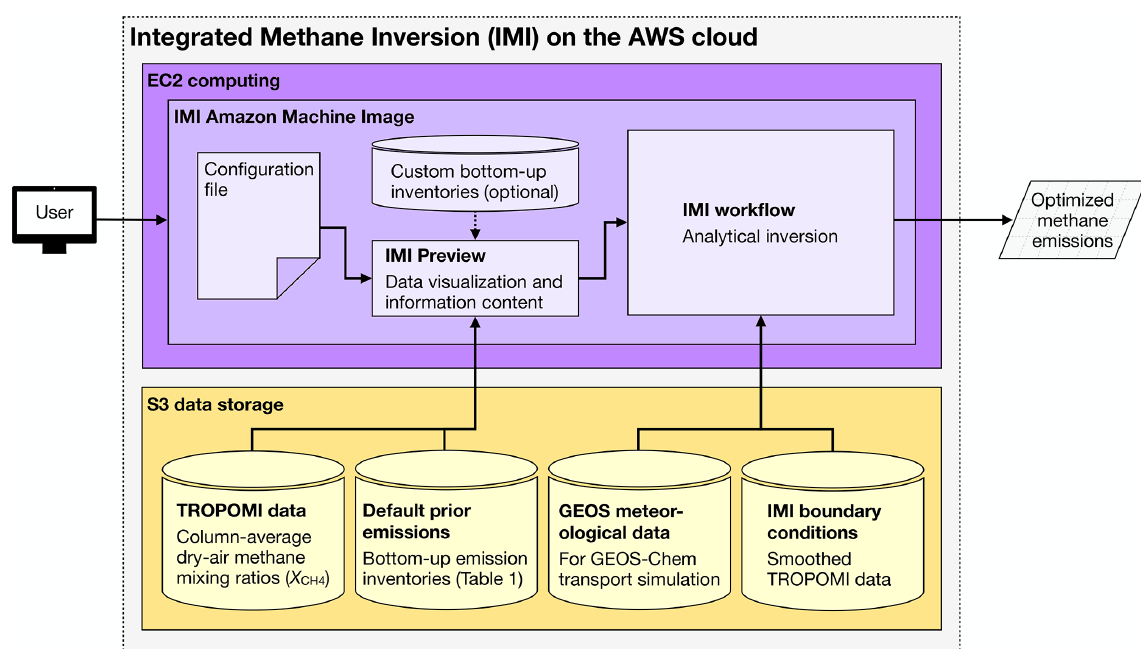
Figure 3. Integrated Methane Inversion (IMI) preview and workflow on the Amazon Web Services (AWS) cloud to infer methane emissions from TROPOMI data. The IMI is accessed as a custom Amazon Machine Image (AMI) on the AWS EC2 computing service. It accesses the operational TROPOMI methane data, GEOS meteorological data, default bottom-up emission inventories, and IMI boundary conditions (smoothed TROPOMI data) from AWS S3 data storage buckets for the desired period. All of these data are resident on the cloud. Users specify their region or period of interest through a configuration file that also allows modification of IMI defaults. They can provide alternative bottom-up emission inventories (instead of the GEOS-Chem defaults) to serve as prior estimates for the inversion. The IMI preview provides visualization of the TROPOMI data and prior emission inventories and a rough estimate of the information content of the inversion (degrees of freedom for signal, or DOFS). Based on this information the user can decide to carry out the inversion through the IMI workflow (Fig. 4) or modify the configuration (see Sects. 2.7 and 4.2 for